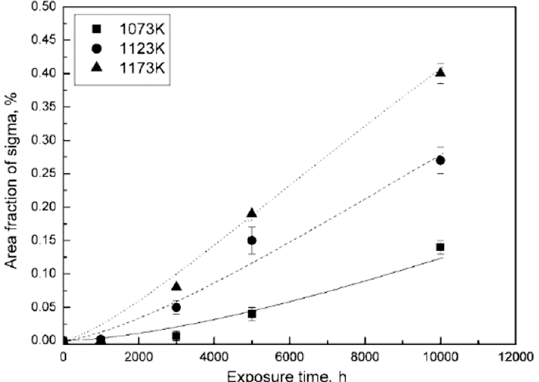
Figure 10. Variations in TCP phase fraction as a function of thermal exposure time in a Re-free Ni-based superalloy [14].